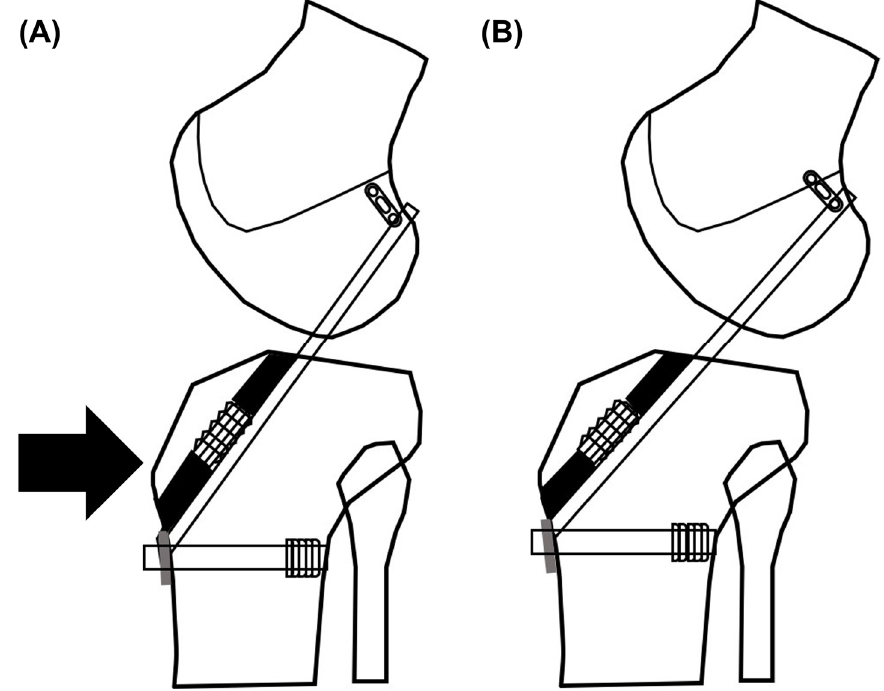
Figure 1. Schematic view of ( A ) a posterior draw force (black arrow) applied and ( B ) a posterior draw force not applied during graft fixation of anterior cruciate ligament reconstruction.